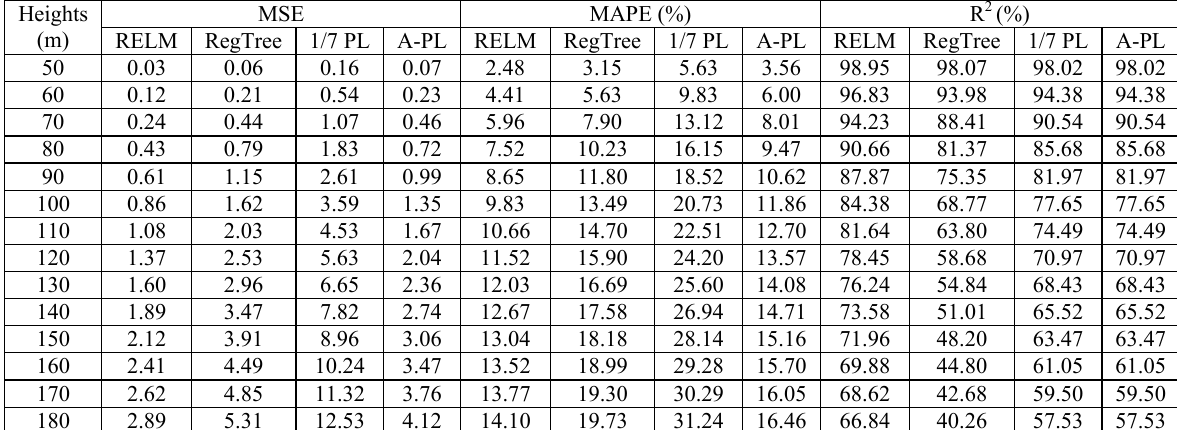
Figure 8. Results for estimation of WS at 180 m based on measurements WS at heights 10-40 m and estimated at 50-170 m. Table 3. Estimated WSs at 50-180 m heights based on measurements at 10-40 m heights using the second dataset